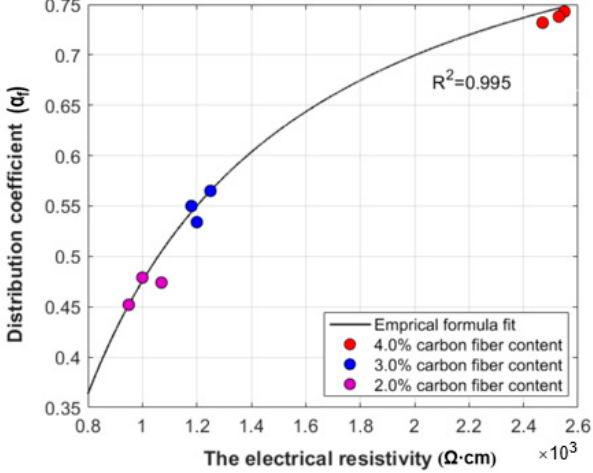
Figure 17. Relationship between the distribution α f and the electrical resistivity ρ c